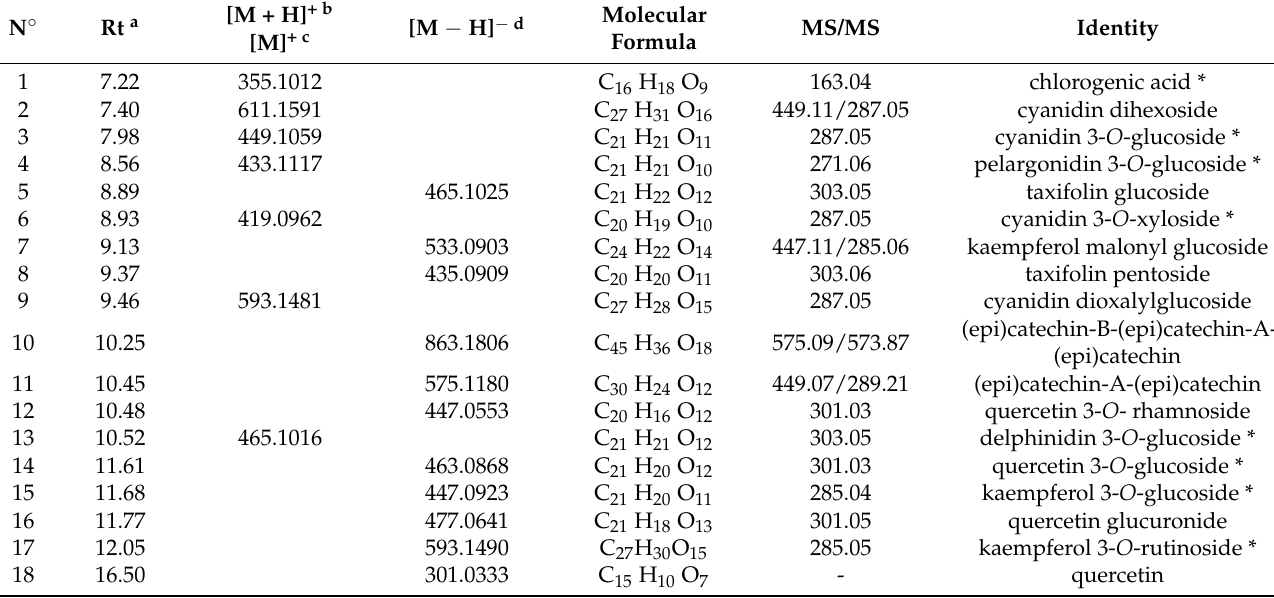
Table 1. Secondary metabolites identified in the extract of blackberries fruits by LC-ESI/LTQOrbitrap/MS/MS n analysis, operating in positive and negative ion